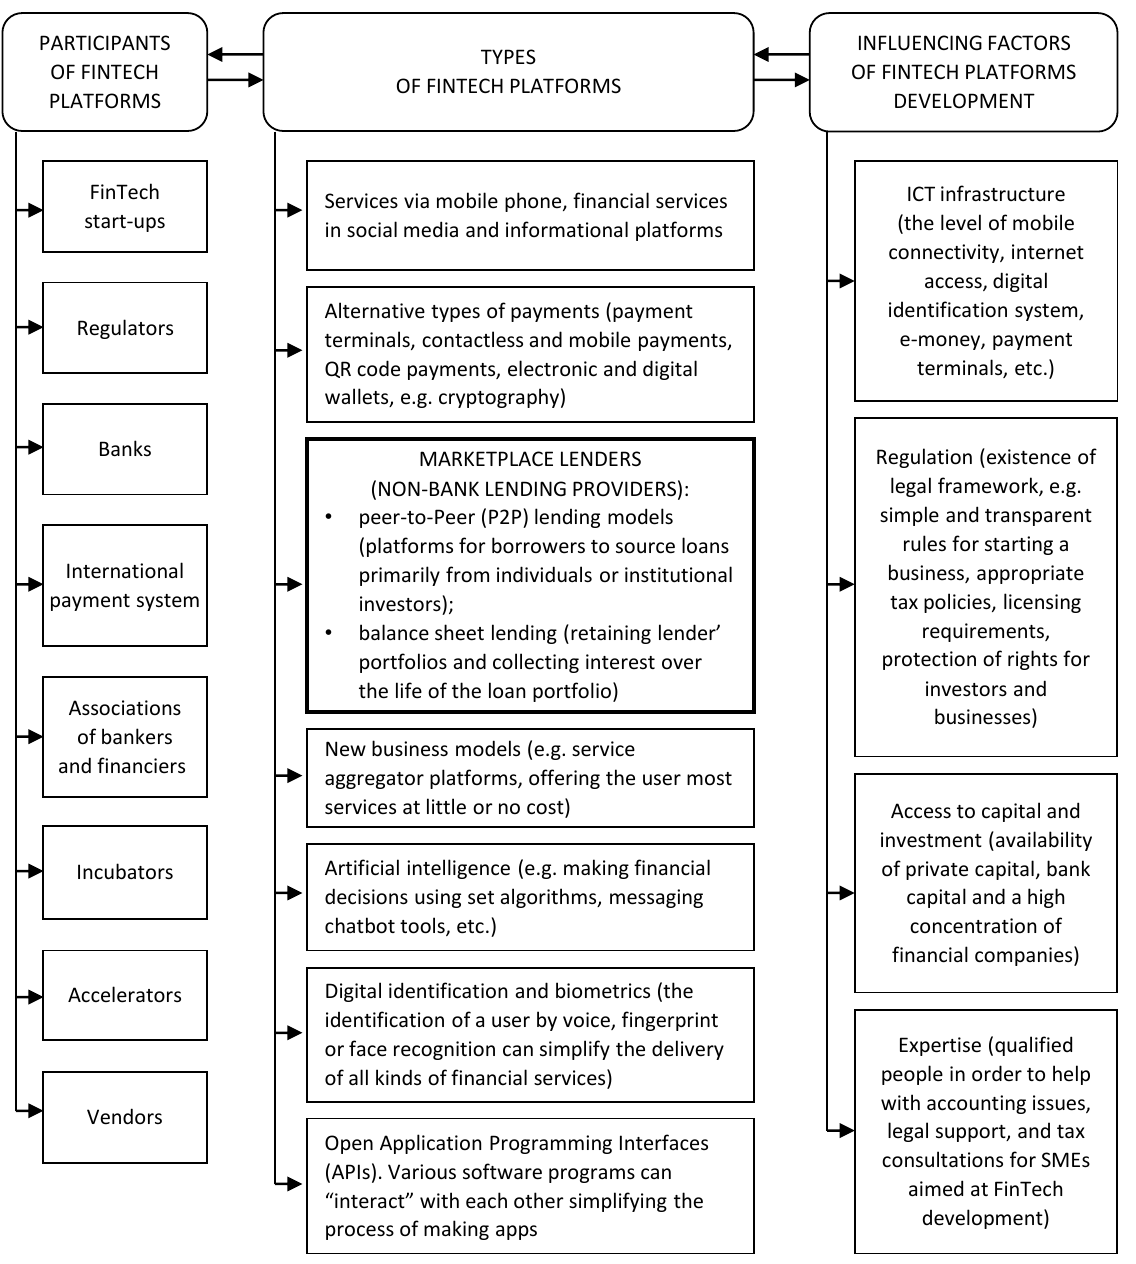
Figure 1. Theoretical approaches to Fintech platform